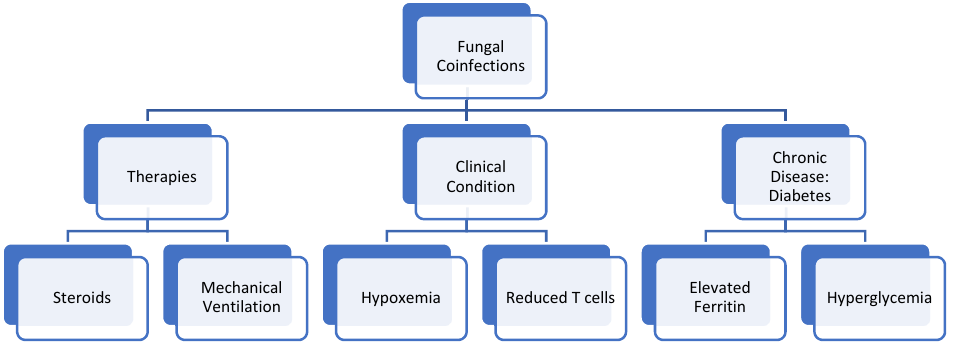
Figure 3. Therapies, clinical conditions, and pre-existing conditions that put patients with COVID-19 at risk for developing Fungal Coinfections.